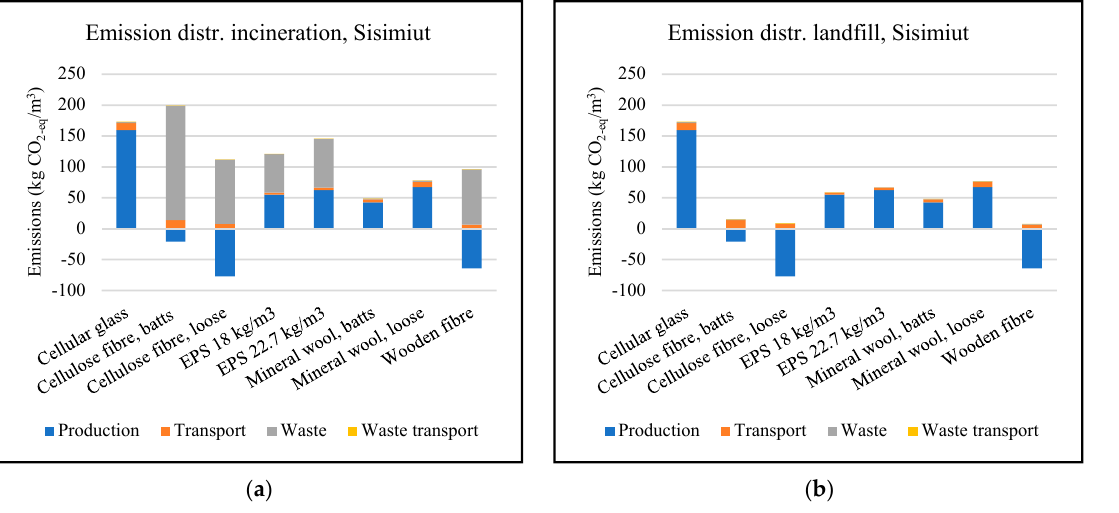
Figure 4. CO 2-eq emissions from the different phases of 1 m 3 insulation material. ( a ) is for incineration and ( b ) is for landfill. See Table 3 for specific data on each material.